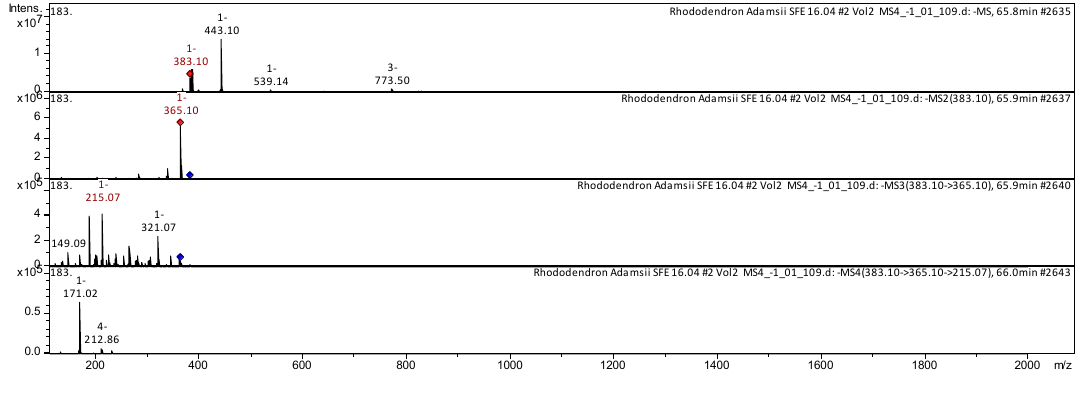
Figure 2. Collision-induced dissociation (CID) spectrum of fraxetin-7- O -beta-glucoronide from Rh. adamsii , m / z 383.10.